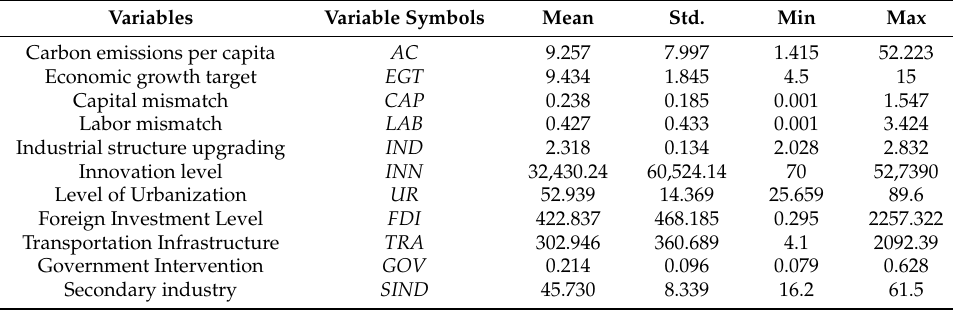
Table 2. Descriptive statistics of